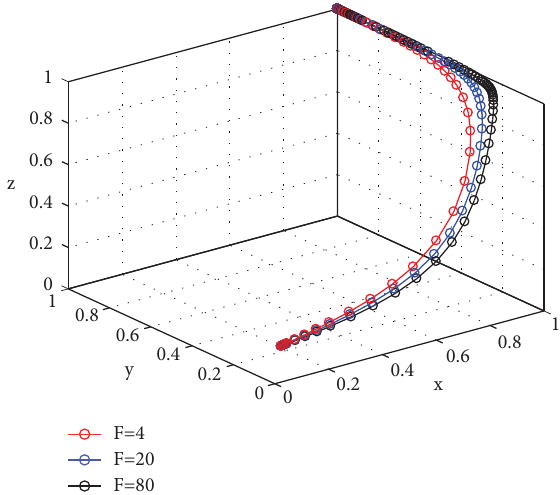
Figure 2: Efect of government fnes on evolution